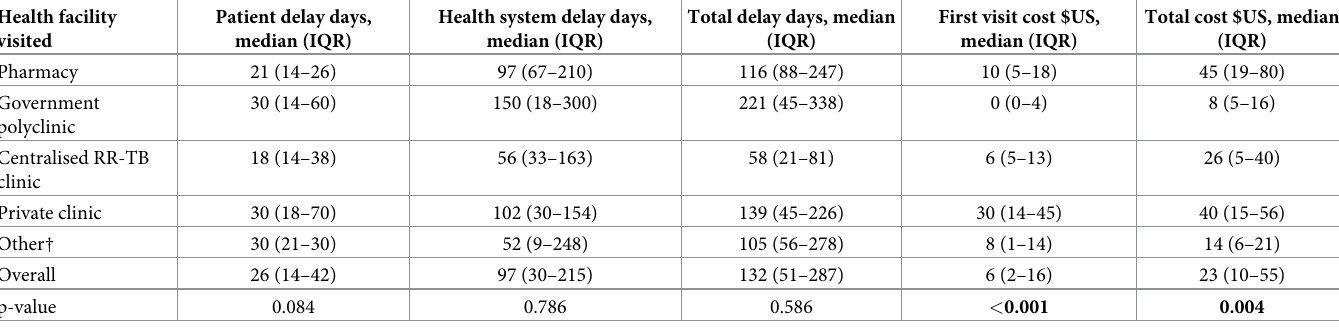
Table 2. RR-TB patients’ first visit to a health care facility, patient time delays, total delay and associated costs to begin effective MDR-TB treatment.